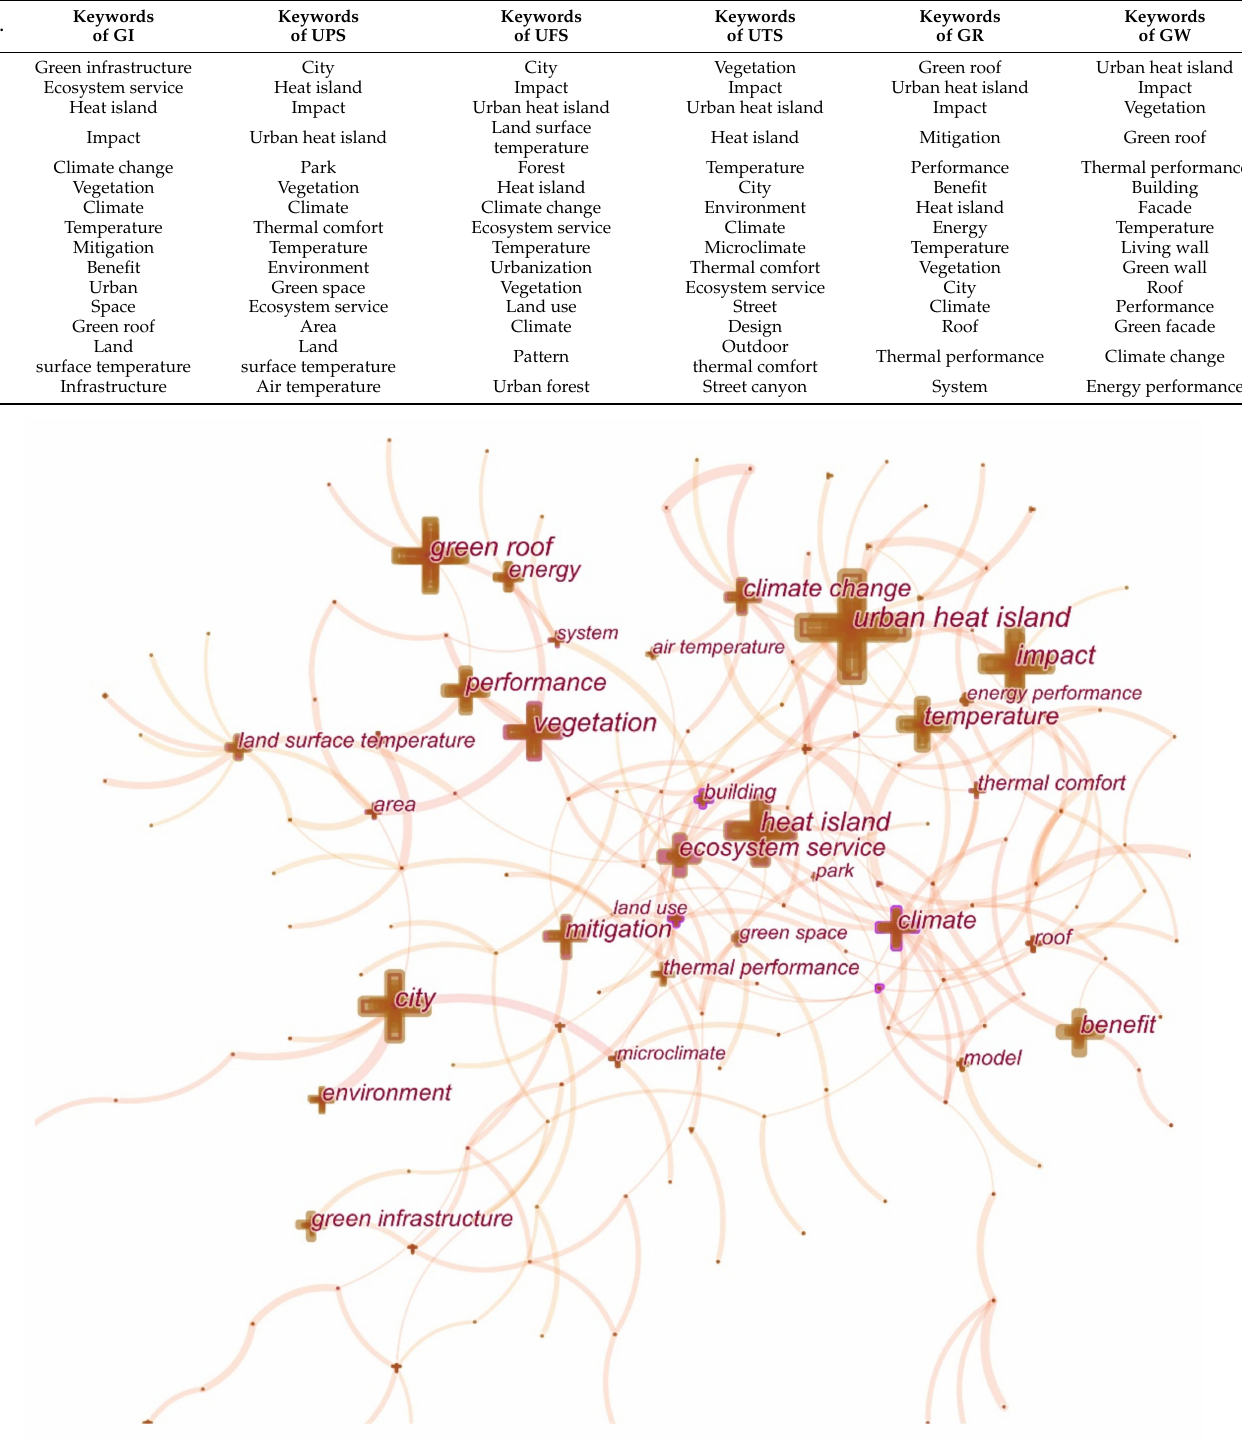
Figure 3. Distribution of the top 30 keywords. Table 1 lists the top 15 most frequently used keywords from different GI types from 1990 to 2021. Among the top three keywords for all the different GI types, the most com- monly appearing ones are “impact” and “urban heat island”, followed by “heat island”, “city”, and “vegetation”, as shown in Figure 3. This shows that these keywords were the most important and more frequently used in this research field than any other